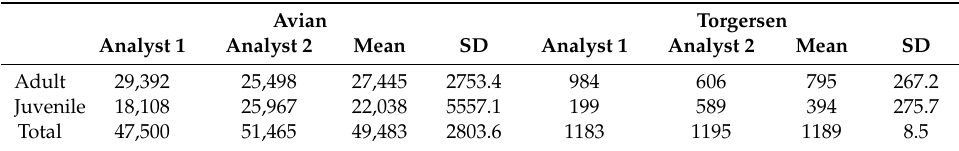
Table 2. Summary of analyst counts on each island. Adult and juvenile penguins in the RGB images were counted by two trained analysts in iTAG to be compared with the output of the workflow. This table shows the counts from each analyst and the mean and standard deviation of the counts for each age class on each island.